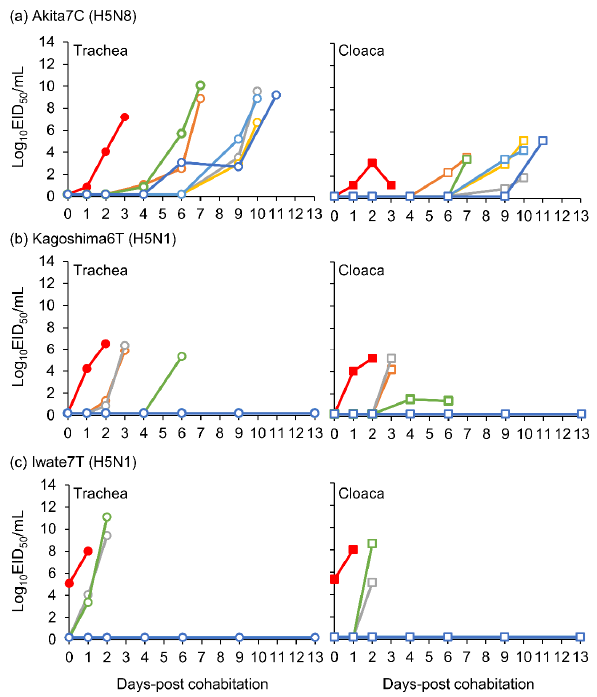
Figure 4. Viral titers in each tracheal and cloacal swab collected from a virus ‐ inoculated chicken and cohabitated chickens (( a ) Akita7C, ( b ) Kagoshima6T, and ( c ) Iwate7T strains). Viral titers in tracheal and cloacal swabs collected from virus ‐ inoculated chickens are represented by red circles and squares, respectively. Viral titers in tracheal and cloacal swabs collected from cohabitated chickens are represented by blank circles and squares (green, orange, blue, light blue, gray, yellow), respectively.